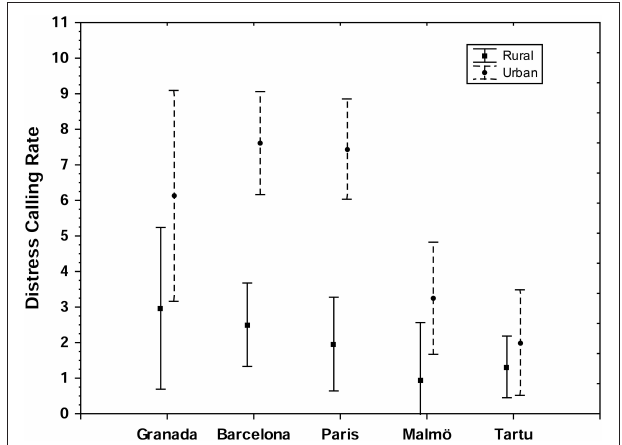
FIGURE 1 | Between-individual variation (mean with standard error) in distress calling rate along habitats (urban vs. rural) and localities (see Table 4 ; both sexes combined). Distress calling rate is number of calls during